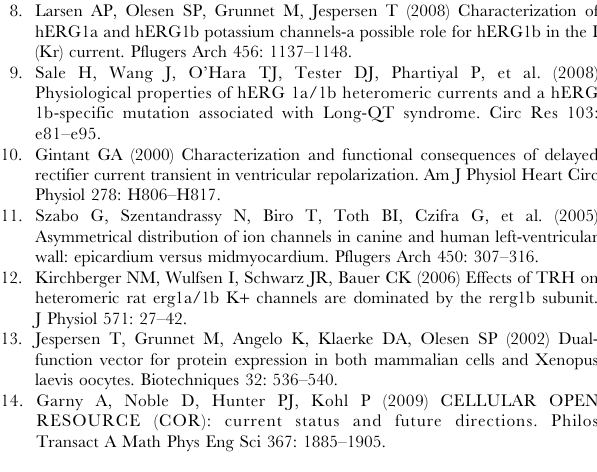
Figure S1 Correlation between macroscopic channel kinetics and isoform abundance. The relative change in the kinetic parameters of deactivation (A, fast component; B, slow compo- nent), recovery from inactivation (C) and activation (D) as compared to hERG1a (0% hERG1b) was calculated based on the values in table S1 and plotted as a function of hERG1b cRNA abundance. The solid lines indicate the linear correlations. The correlation coefficients are also shown. In C, the dotted line and the open square indicate the extrapolated value for hERG1b. Figure S2 Comparison of deactivation kinetics for observed and theoretical currents. A-D, Calculations of observed and theoretical time course of current decay are shown for different relative abundances of hERG1b as indicated. The observed current decay (Exp, solid lines) in each situation was calculated from the observed macroscopic deactivation properties (table S1). The theoretical current decay (Theory, dotted lines) was calculated under the assumption that only hERG1a and hERG1b channels were formed. Notice that for all comparisons the observed currents decay faster than the theoretical